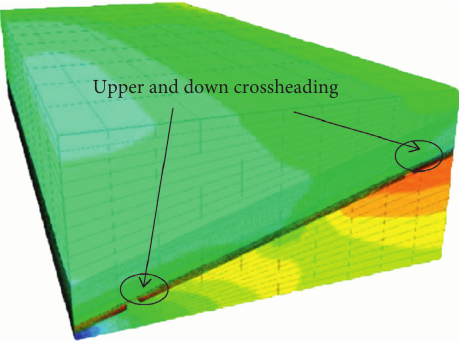
Figure 6: Model horizontal stress cloud diagram.